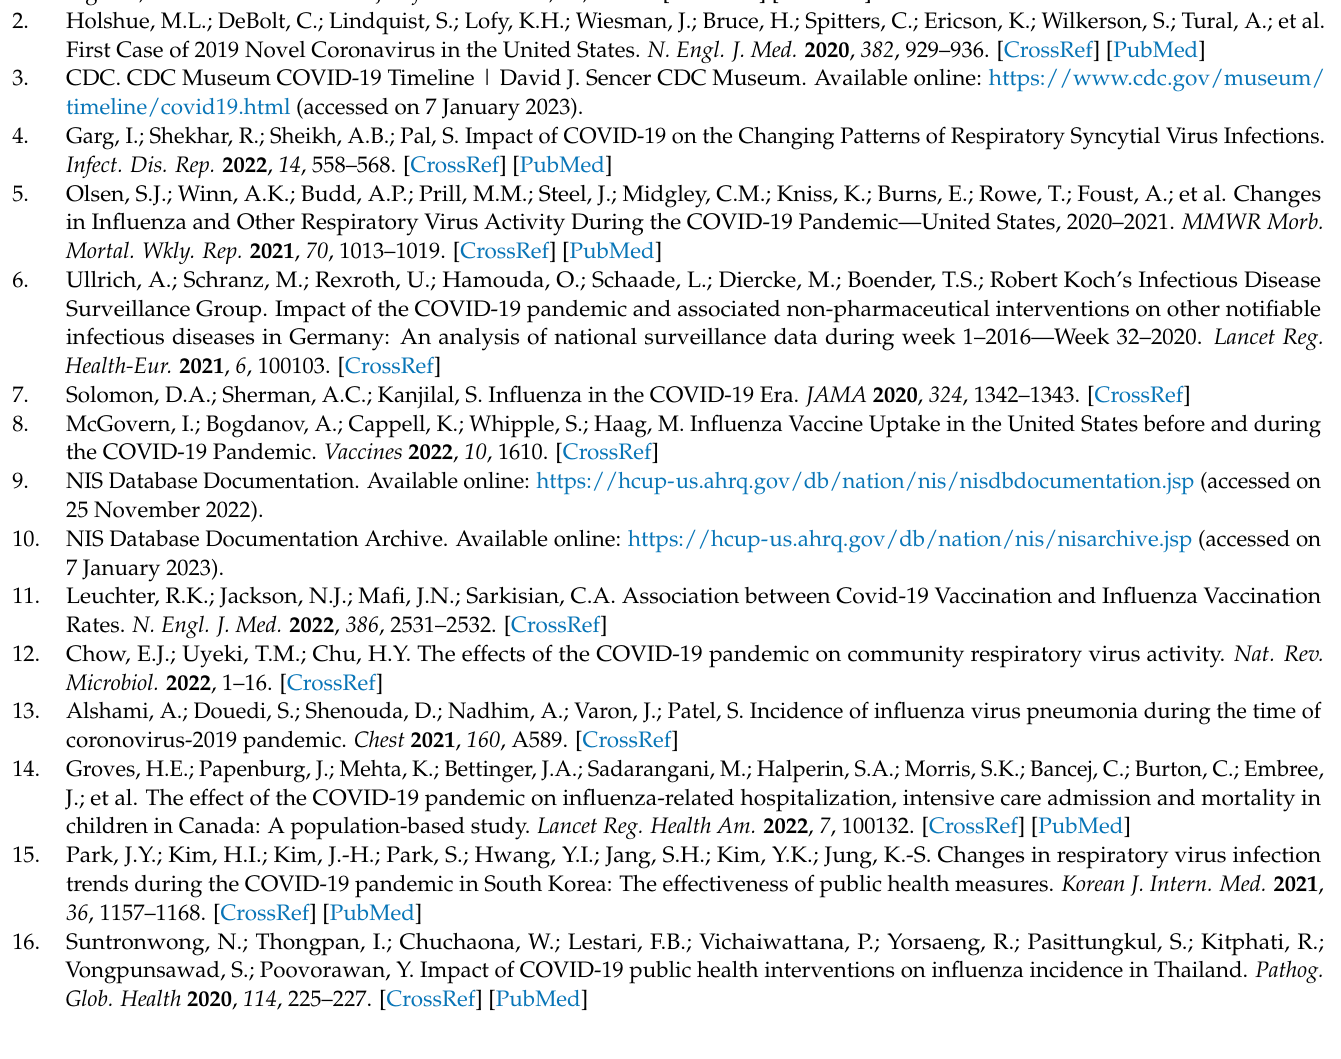
Table S6: Parainfluenza mortality by month from 2017–2020 with absolute number and percentages; Table S7: Human Metapneumovirus (MPV) admissions by month from 2017–2020 with absolute number and percentages; Table S8: Human Metapneumovirus (MPV) Mortality by month from 2017–2020 with absolute number and percentages; Table S9: COVID-19 admissions by month in 2020 with absolute number and percentages; Table S10: COVID-19 Mortality by month in 2020 with absolute number and